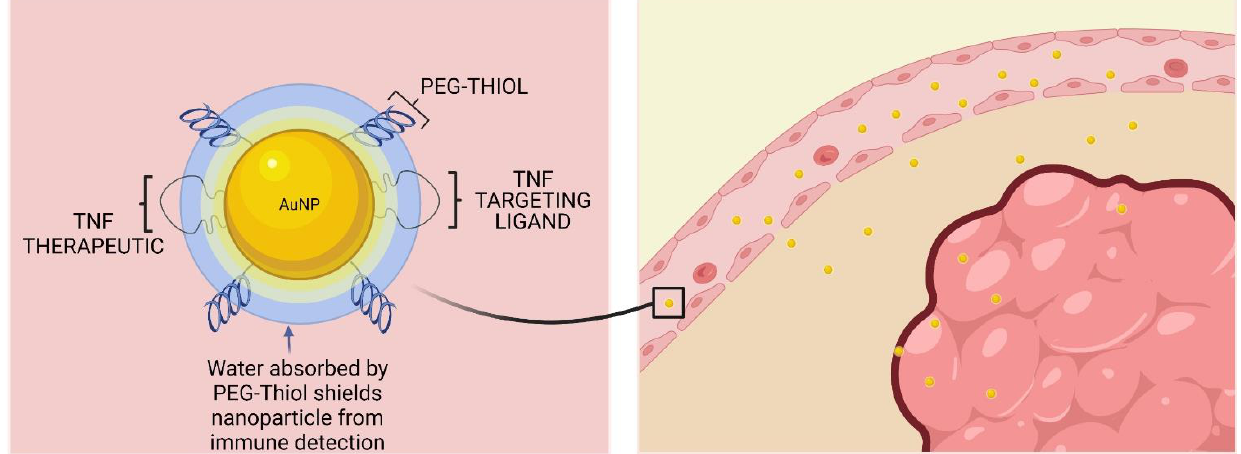
Figure 7. Design and mode of action of CYT-6091 (Aurimune ® ). The blood vessels of tumors are weak, resulting in gaps in the walls. When CYT-6091 reaches these blood vessels, the nanoparticles are small enough to pass through the resulting cavities to their target, the tumor. Tumor tissue generally has a leaky neovessels, which allow nanoparticles to pene- trate and accumulate easily [123]. Methotrexate (MTX), a drug for cancer treatment, upon conjugation with AuNPs, exhibited a faster rate of accumulation and higher cytotoxicity towards various tumor cell lines compared to free MTX [124]. Biodistribution and proper release of the drug tethered to the NPs is dependent on the type of the linker used to their functionalization. Wang et al. developed a system with doxorubicine (DOX) attached to the surface of AuNPs with acid-labile linkages [125]. When it was introduced to MCF- 7/ADR cancer cells, highly efficient cellular entry, intracellular release of DOX, and en- hanced retention were observed when compare either to free DOX or DOX attached using carbamate linkages. Hormone receptors of the tumor can be targeted using AuNP drug delivery systems. In the study by El-Sayed and colleagues, they used tamoxifen to both target and deliver AuNP to breast cancer cells that overexpress estrogen receptor [126]. By targeting the estrogen receptor, tamoxifen (TAM) was chemically modified using PEG- thiol and covalently bound to 25 nm AuNPs with approximately 12,000 TAMs per parti- cle. AuNP-TAM conjugates demonstrated a 2.7-fold greater efficacy in human breast can- cer cells (MCF-7) compared to native TAM due to increased intracellular transport of ta- moxifen by nanoparticle endocytosis [120,127]. El-Sayed and colleagues developed an- other drug delivery system targeting elevated levels of androgen receptors in prostate cancer. Androgen receptor targeting was achieved by modifying antiandrogen chemo- therapeutic agents with PEG-thiol to facilitate binding to 30 nm AuNPs. There was an approximately 10-fold increase in the therapeutic efficacy of antiandrogens in chemother-